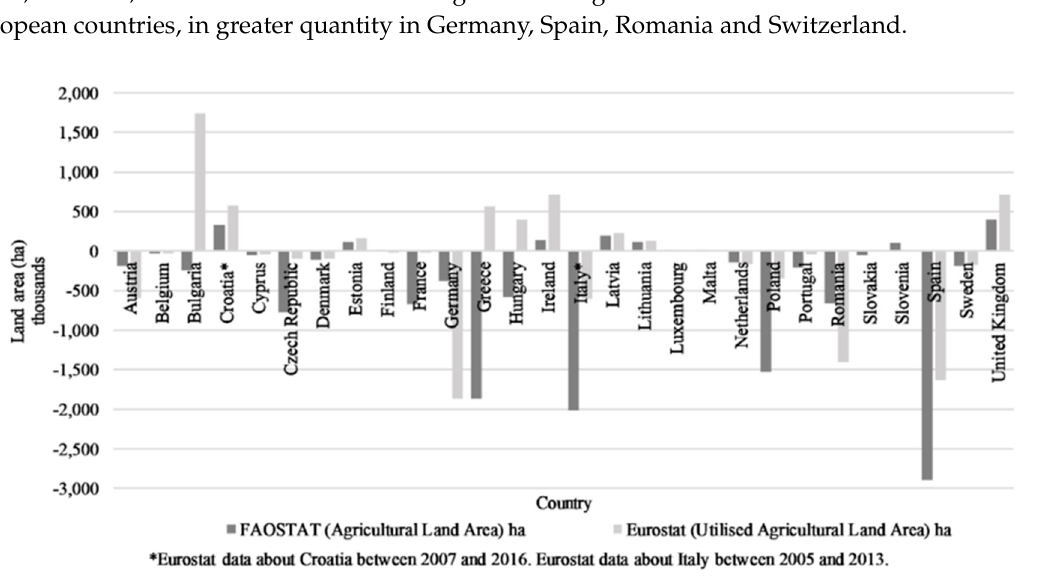
Figure 2. Utilised agricultural land (Eurostat) and agricultural land (FAOSTAT) use change (ha) in Europe between 2005 and 2016.